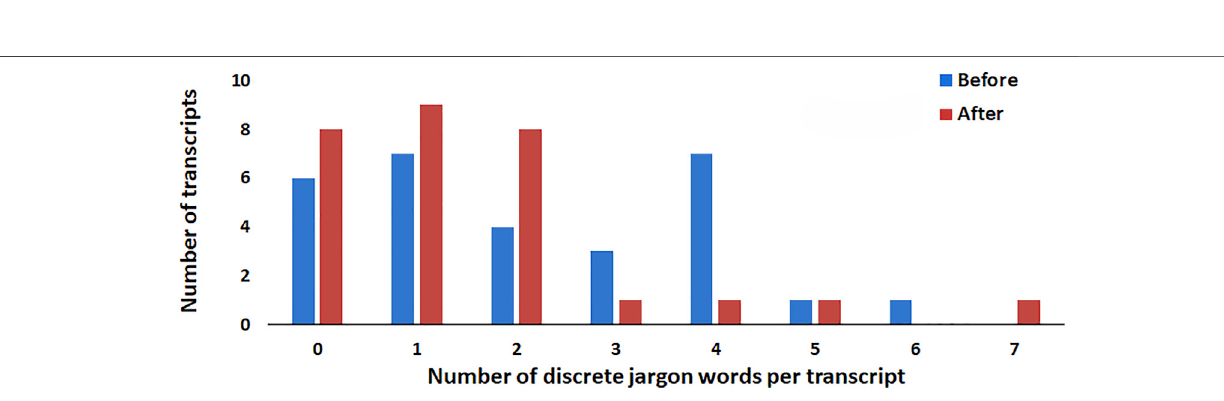
Frontiers in Communication |